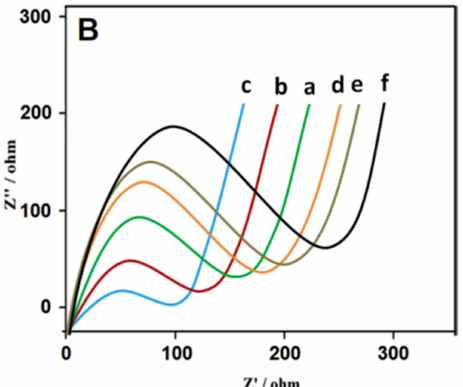
Figure 8. Nyquist plots at ( a ) unmodified GCE, ( b ) GO / GCE, ( c ) AuNPs-ATP-GO / GCE, ( d ) after immobilization of Ab 1 on AuNPs-ATP-GO / GCE, ( e ) after blocking of the interface by BSA, and ( f ) after incubation with PSA. Abbreviations: GO: graphene oxide; AuNPs: gold nanoparticles; ATP: p -aminothiophenol; BSA: bovine serum albumin; PSA: prostate specific antigen. For other abbreviations see the text. Reprinted from ref. [64], Copyright (2020), with permission from